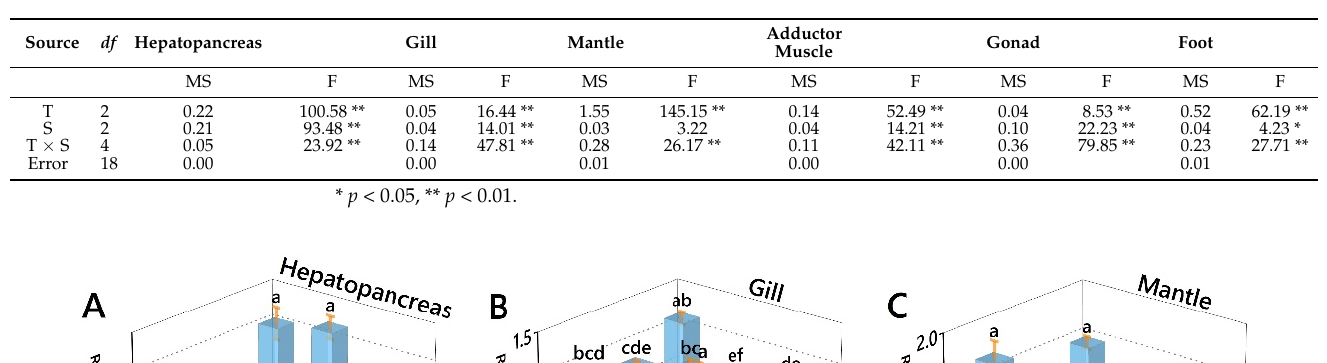
Table 6. MANOVA results using a generalized linear model for the main and interaction effects of temperature and salinity on the GPX relative expression level of Perna viridis .